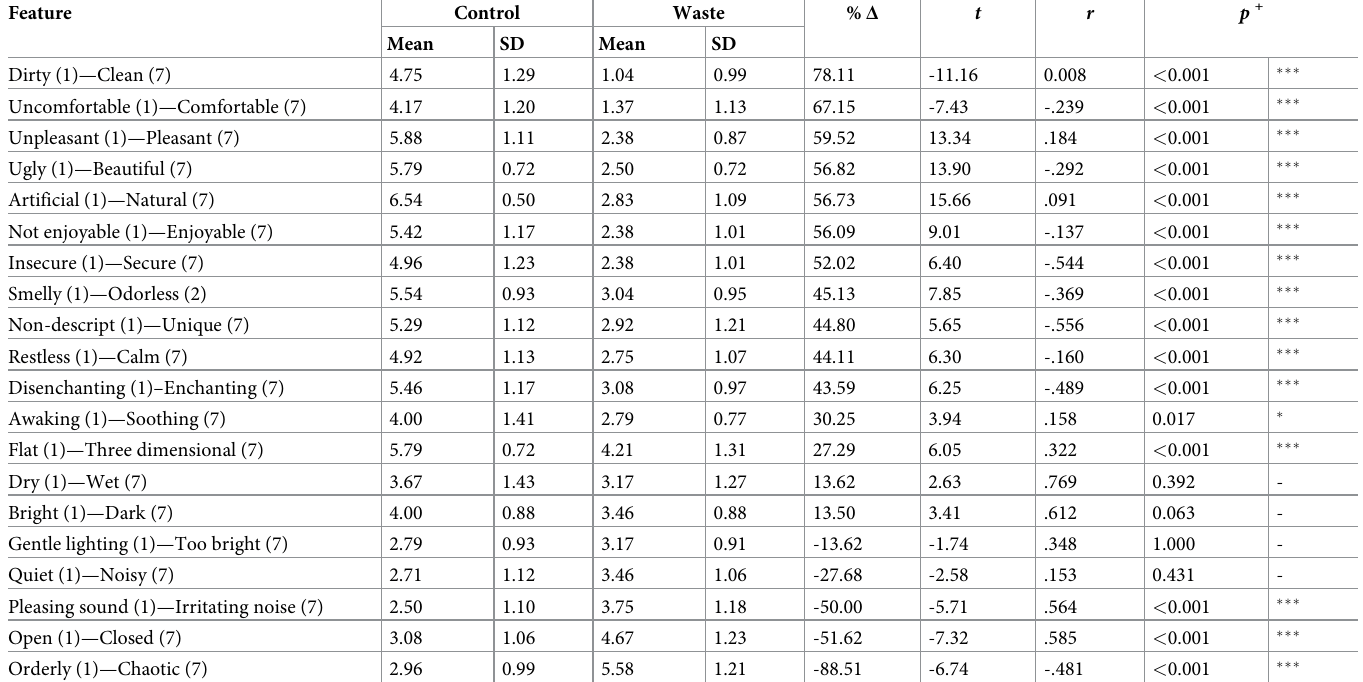
Table 2. Results of a t-test comparison between the control and waste settings (semantic differential method). Feature Control